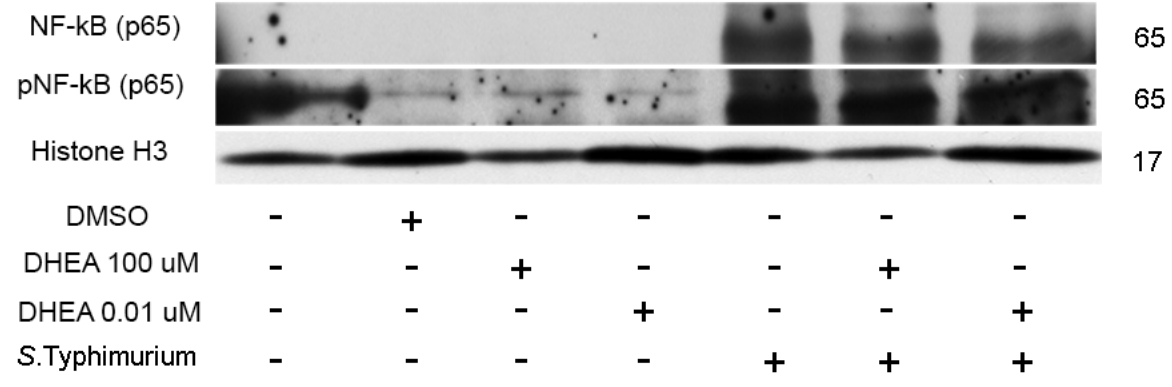
FIGURE 6 – DHEA can modulate the phosphorylation of NFkB. Neutrophils (5 x 10 6 ) were treated with 100 µM and 0.01 µM DHEA and infected with S. Typhimurium for 1 h. Then, cells were washed and the proteins were extracted with CelLytic Mammalian Cell Lysis/Extraction Reagent using phosphatase and protease inhibitor cocktails. The proteins were quantified using the Bradford method and 20 µg of protein were separated using SDS-PAGE. The protein was transferred to a nitrocellulose membrane, and anti-NFκB and anti-p-NFκB antibodies were used for detection. In this experiment, a pool of protein derived from cultures of neutrophils isolated from 3 individuals was